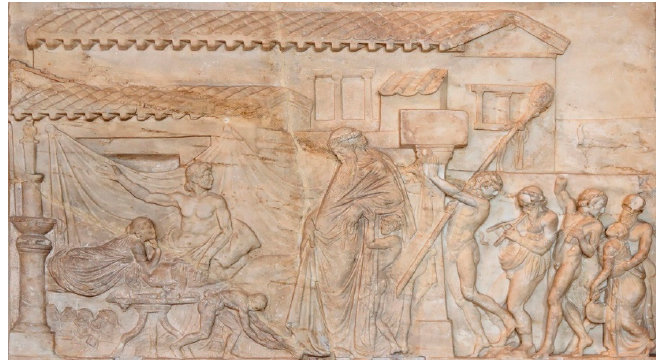
Figure 11. Relief of the so-called ‘Ikarios’ type (first or second century AD, based on a Hellenistic prototype), Louvre MA 1606; © Public domain